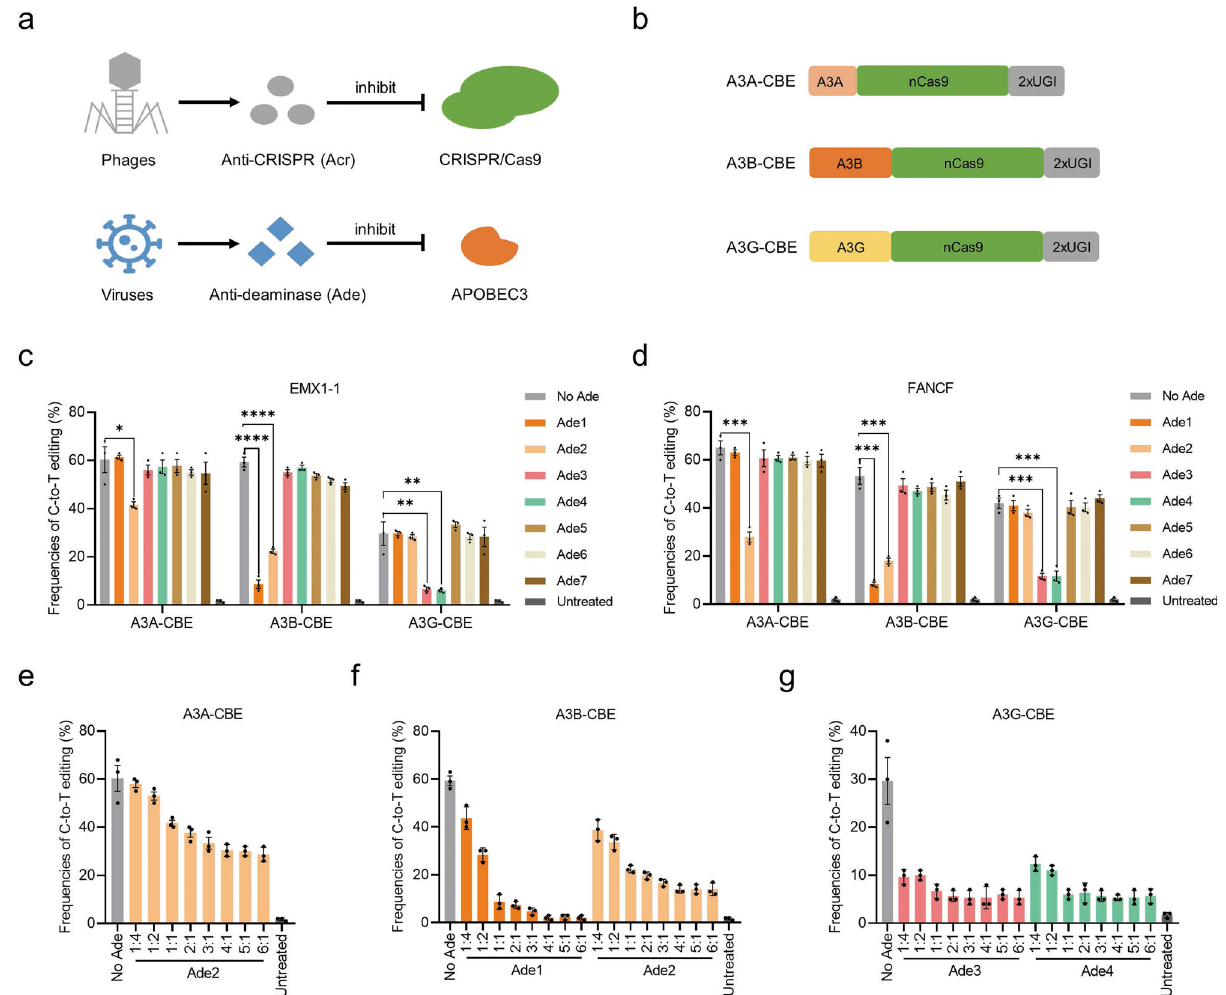
Fig. 1 Viruses derived Ades ef fi ciently inhibit A3-CBEs. a Schematic representation of anti-CRISPR and anti-deaminase. b Schematic representation of three A3-CBE architectures. nCas9, D10A. c , d Base editing of A3A-, A3B- and A3G-CBE in the presence or absence of the seven Ades at the EMX1-1 ( c ) and FNACF ( d ) sites. Plasmids expressing CBE, sgRNA, and each Ade (1:1:1) were cotransfected into HEK293T cells. e – g Inhibition of A3A-CBE ( e ), A3B- CBE ( f ) and A3G-CBE ( g ) with different doses of Ades at the EMX1-1 site. The ratio of Ade:CBE ranging from 1:4 to 6:1. Values and error bars re fl ect the mean ± s.e.m. and n = 3 biologically independent experiments. All p values were calculated by two-sided t tests. * p < 0.05, ** p < 0.01, *** p < 0.001, **** p < 0.0001. Source data are provided as a Source Data fi le.